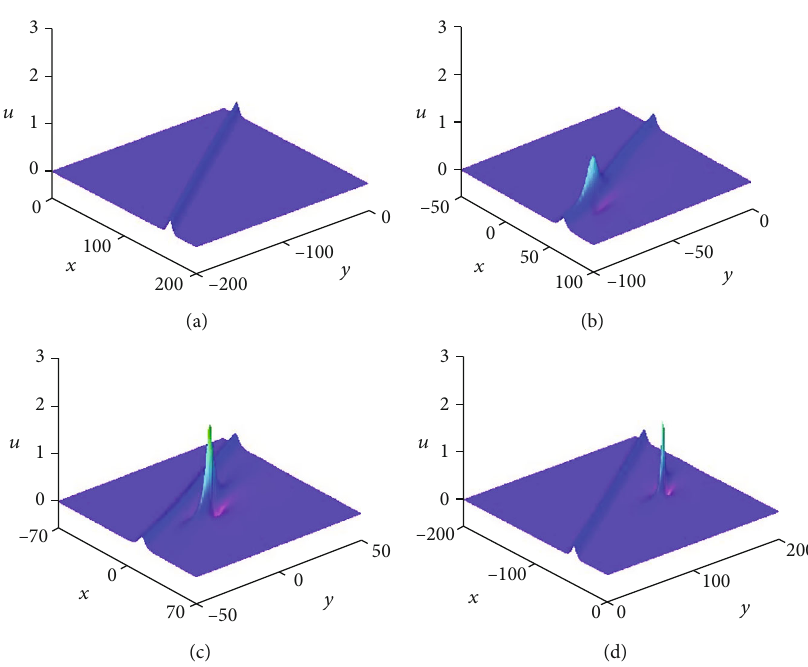
= 1/20 , a = 2 , k = 1/10 , a 1 5